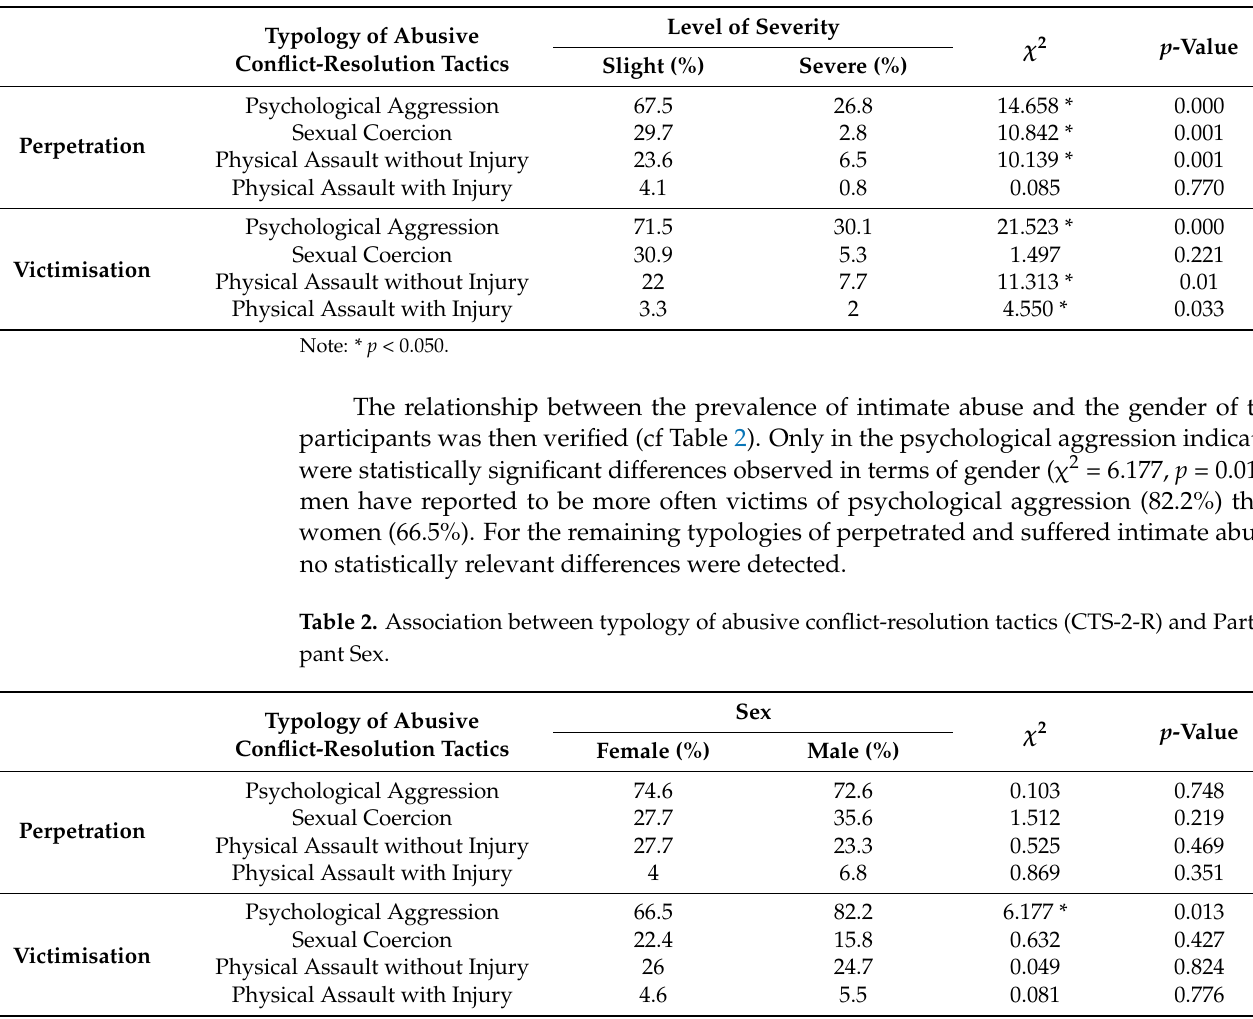
Table 1. Frequencies and statistical differences between slight and severe conflict-resolution tactics (CTS-2-R).